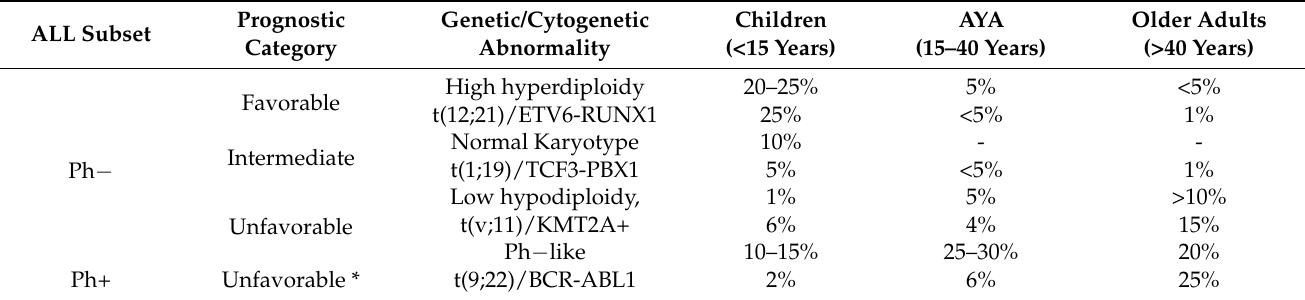
Table 1. Summary table comparing the age-related incidence (percent of all evaluable cases) of main genetic/cytogenetic abnormalities in BCP ALL (data adapted from Roberts KG et al.